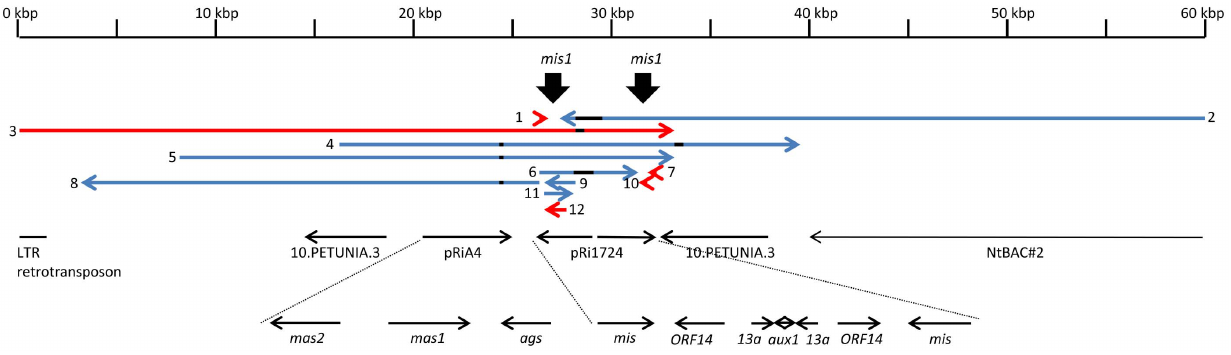
Figure 1. Scheme of position of N.tabacum contigs containing mis1 . Nicotiana tomentosiformis contigs are given in red, N. tabacum contigs are blue,gaps within contigs are black. Bold black arrows point to the mis 1 sequences. Black arrows under the scheme of contigs show position and orientation of sequences homologous to the contigs: 1: ASAG01208860, 2: AYMY01187867, 3: ASAG01039652, 4: AWOK01262755, 5: AWOJ01062996, 6: AWOJ01534161, 7: ASAG01205334, 8AYMY01187868,9-AYMY01393623,10-ASAG01208934,11-AWOK01658345, and 12-ASAG01214370.